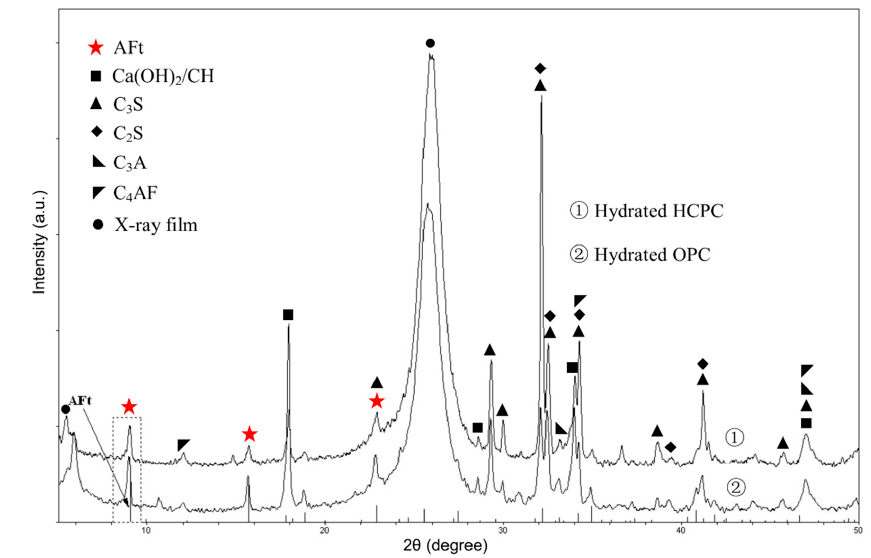
Figure 1. XRD patterns of the hydrated HCPC and OPC after 23 h.